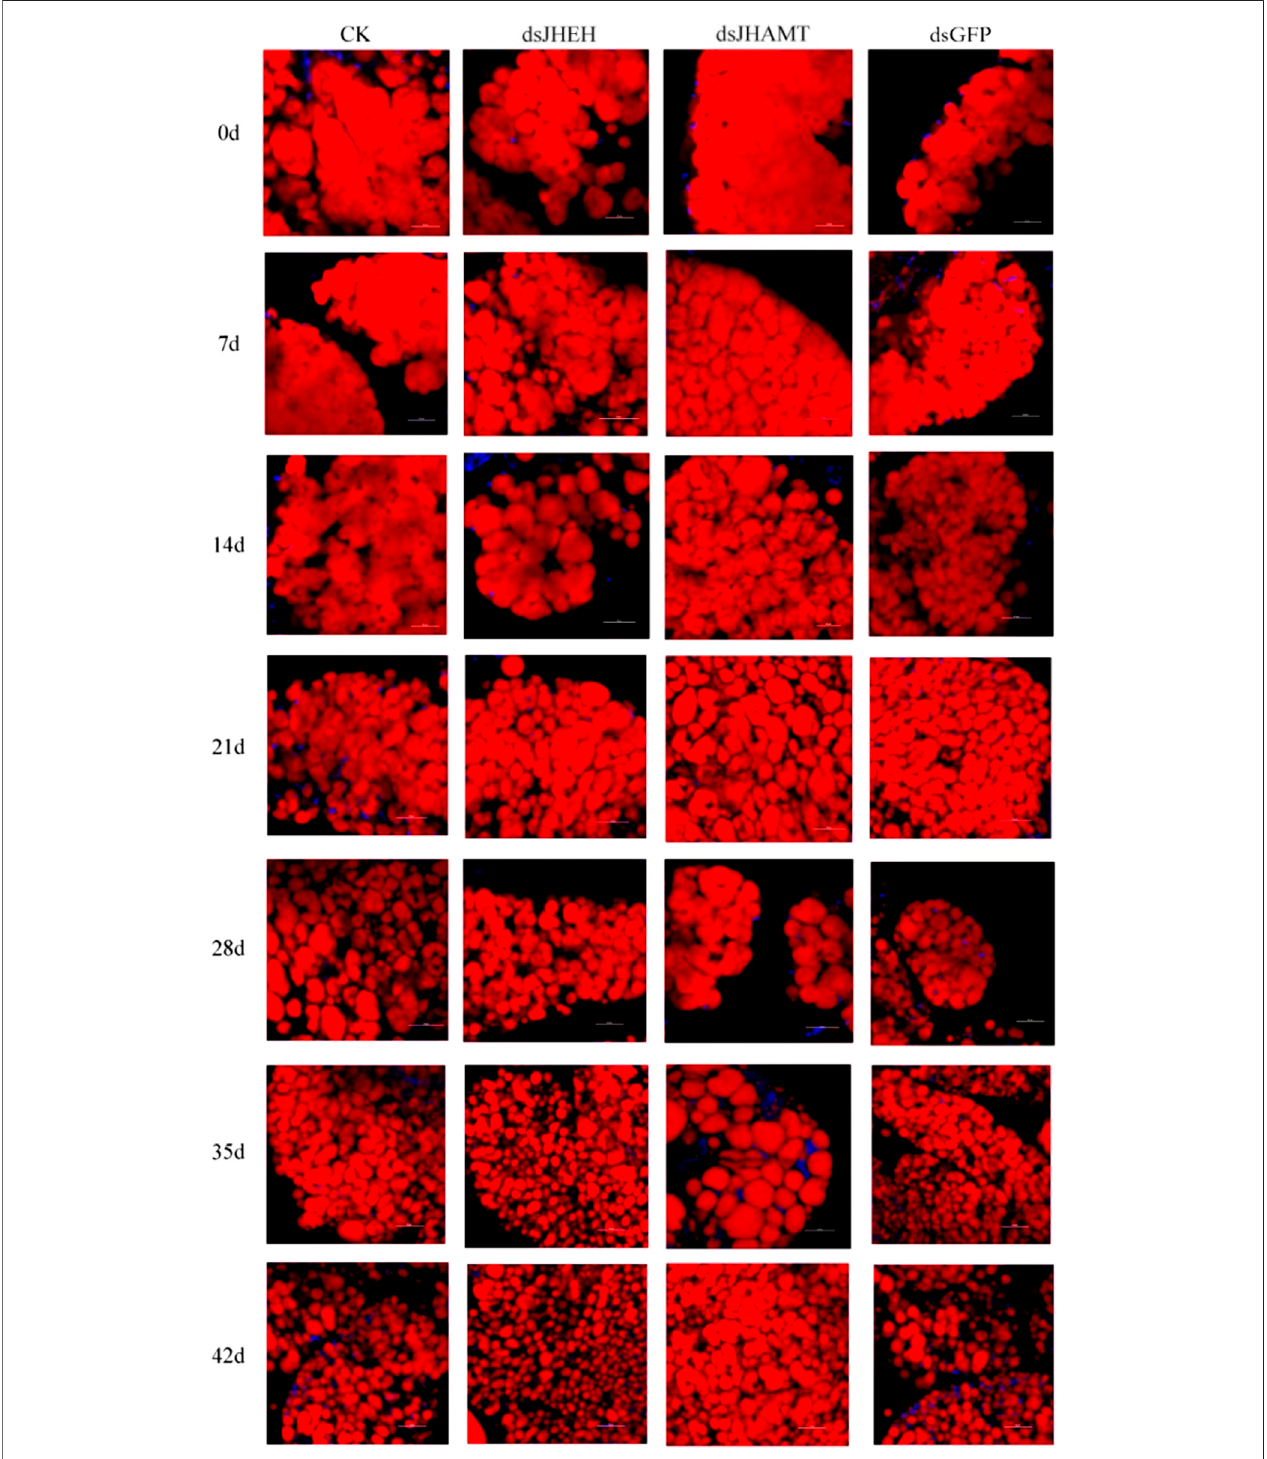
FIGURE8| LipidchangeinthefatbodyafterinjectionofdsRNAin A.chinensis .RedsignalindicatesthelipiddropletsstainedbyNileRed,andbluesignalindicates the nucleus stained by DAPI.